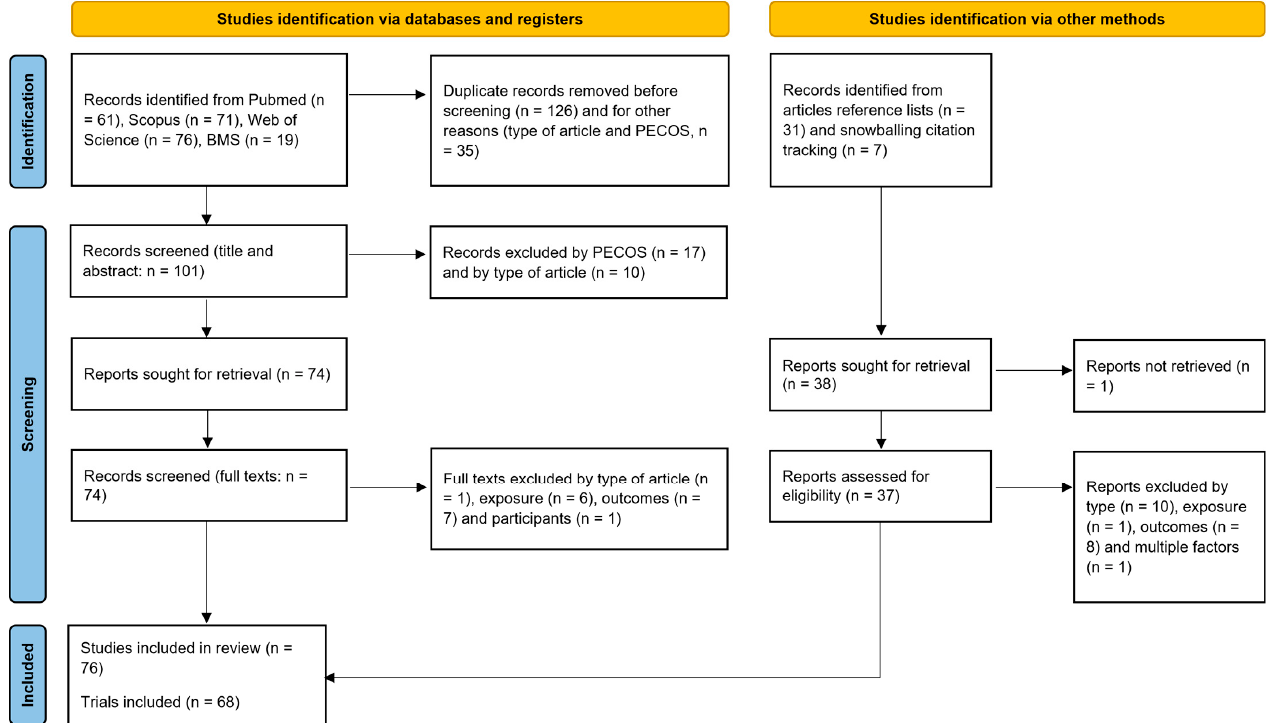
Figure 1. Search and screening processes used in the current study displayed as a PRISMA 2020 flow diagram.